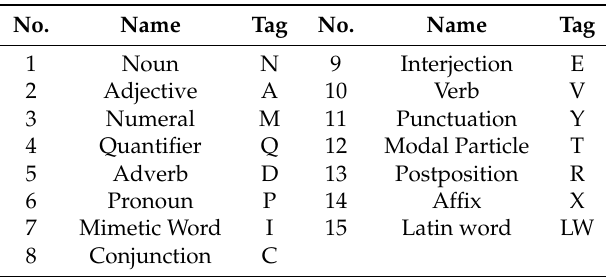
Table 3. First-level POS tagging set for Uyghur.